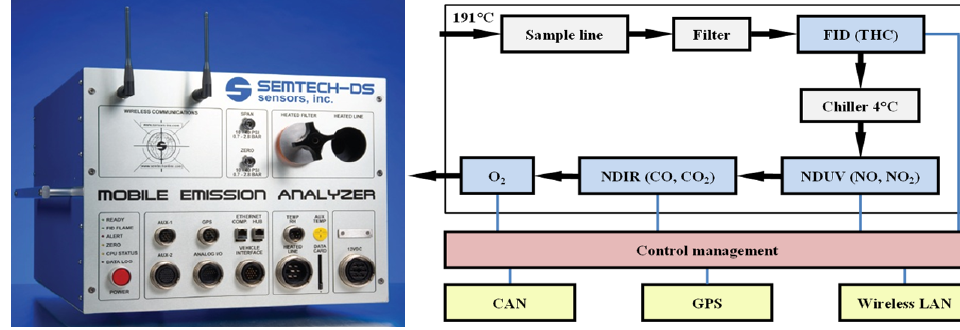
Table 2. Semtech DS technical specifications.